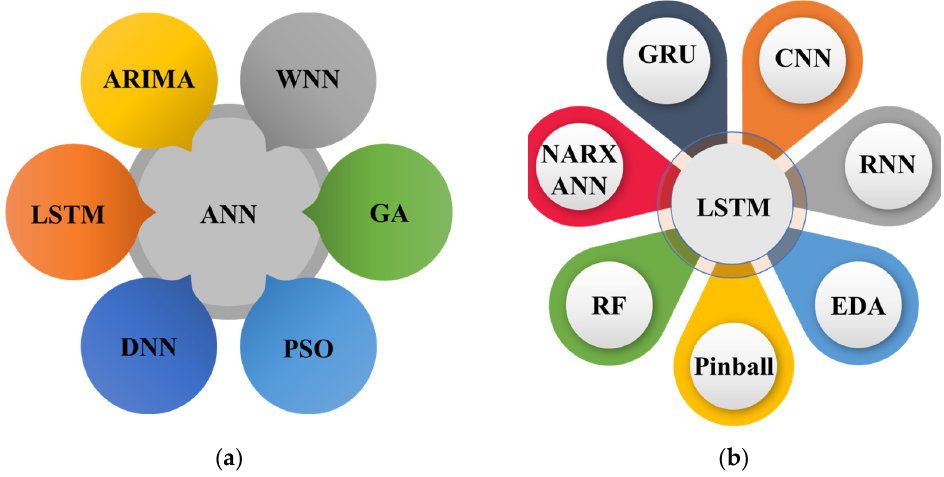
Figure 4. Different ensembles of E.L.F. models used in literature: ( a ) ANN; ( b ) LSTM.